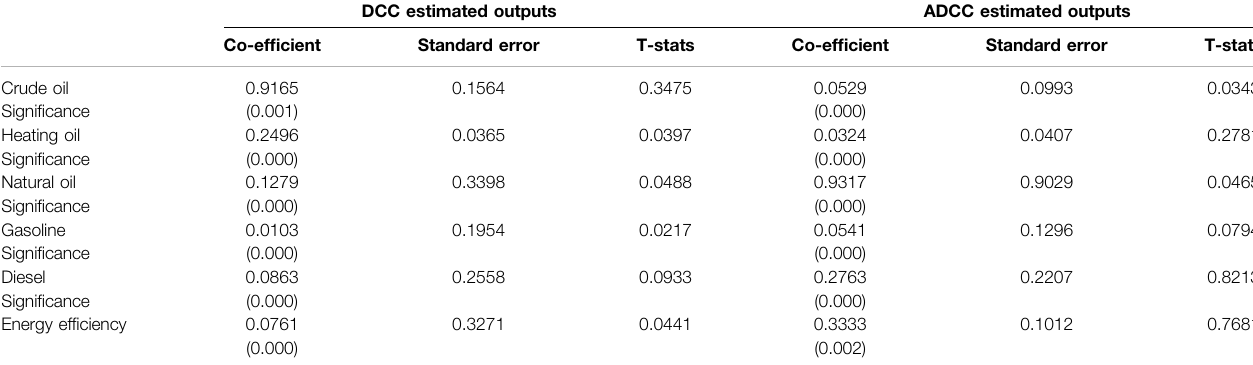
TABLE 5 | DCC-ADCC fi